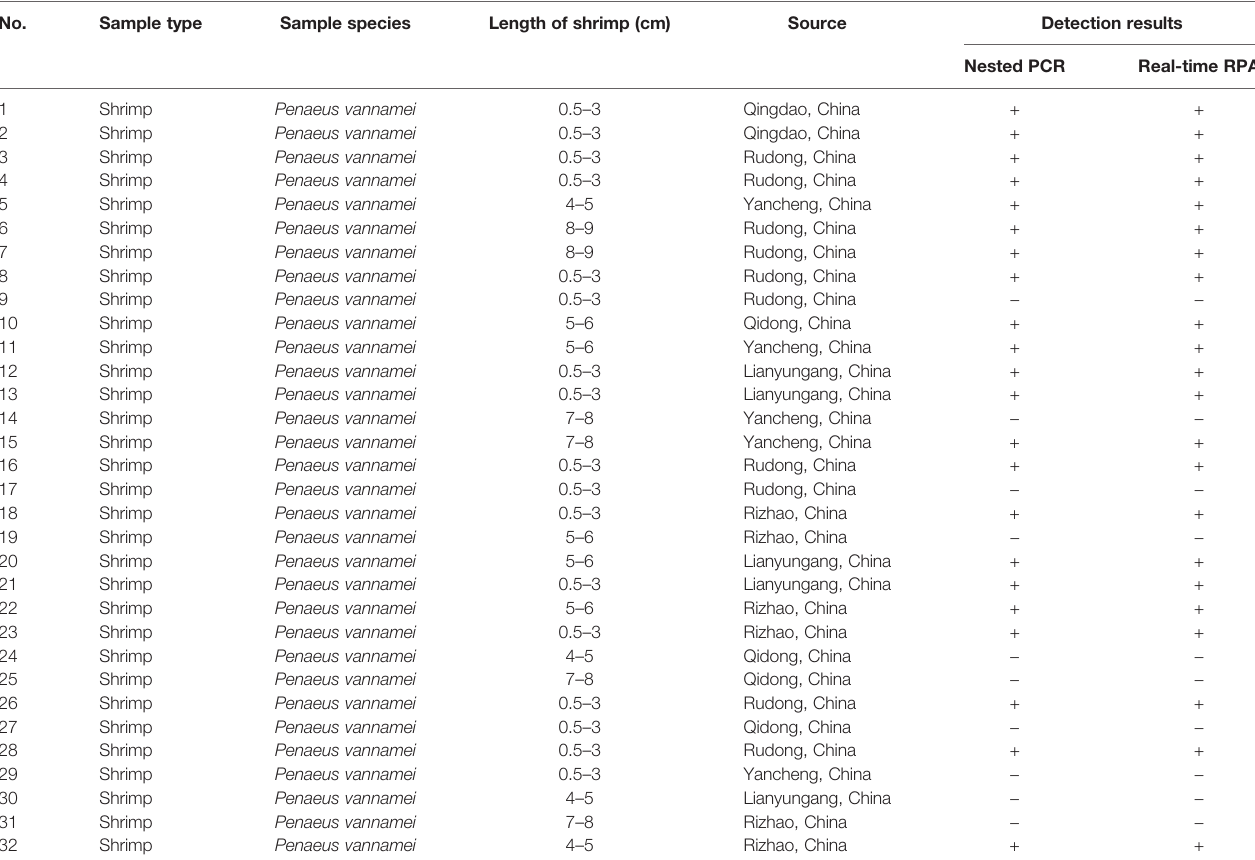
TABLE 3 | Detection of Enterocytozoon hepatopenaei (EHP) infection in clinical samples. No.